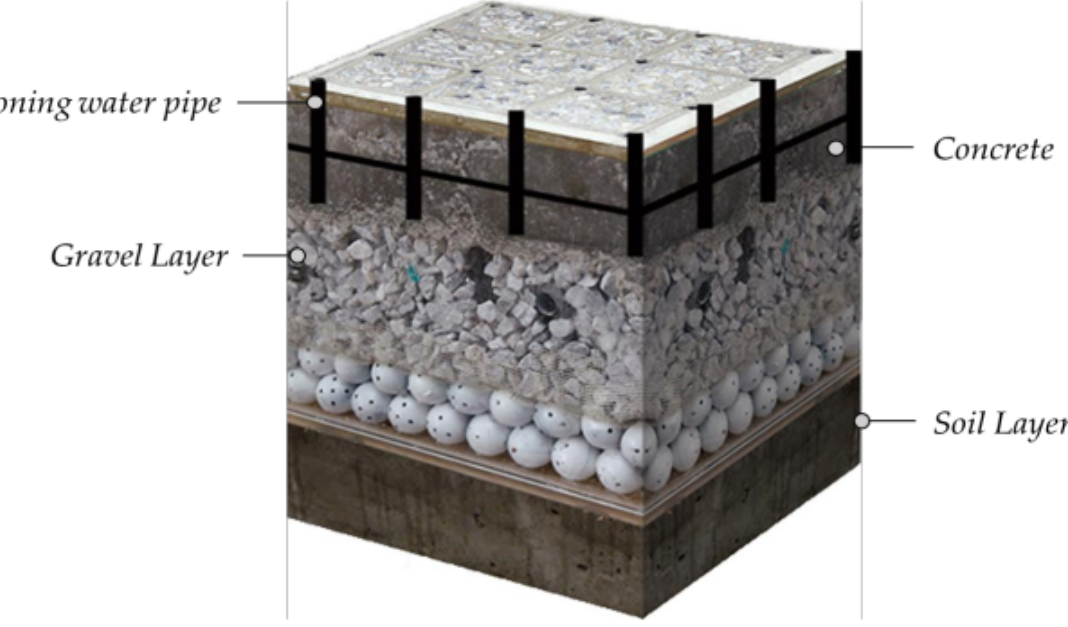
Figure 1. The profile of JW ecological technology. Modified from: CHYI SHYANG CO., LTD.